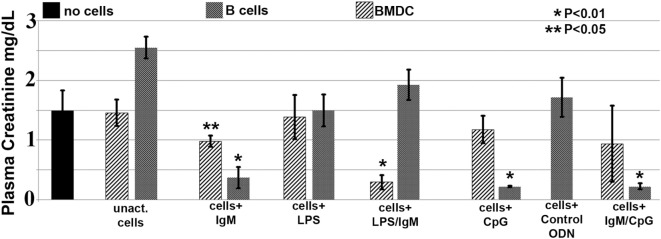
IgM-pretreated B cells are more protective than IgM-pretreated BMDC in preventing ischemia-induced acute kidney injury. Unlike with BMDC, addition of LPS negates the protective effect of IgM-pretreated B cells. CpG activation, unlike LPS, renders B cells, but not BMDC, protective. Use of B cells pretreated with isotype control IgM was not protective (data not shown). Each data point is a mean of at least three separate experiments with at least six mice. * and ** denotes significance (one-way ANOVA) compared to renal ischemia without cell therapy (black bar).